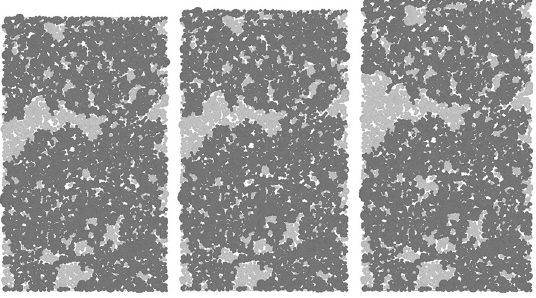
Fig. 6 Top view of a series of instances of a script-generated gra- phene ink model that correspond to different values of